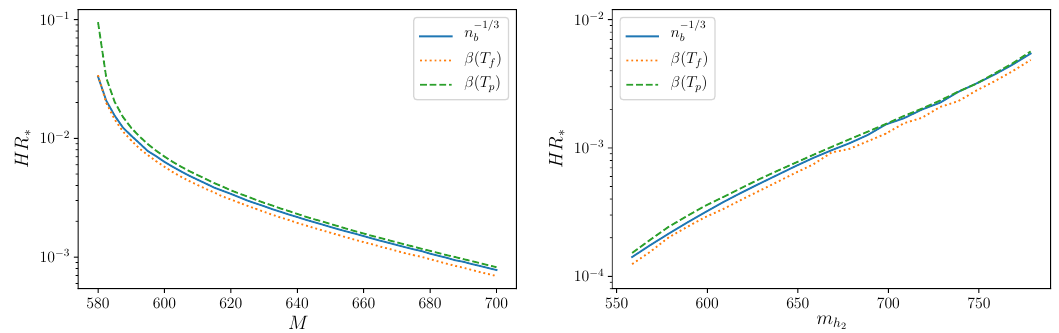
Figure 13 . The mean bubble separation times the Hubble parameter for SMEFT ( left ) and xSM ( right ). The solid line corresponds to the numerically calculated value defined in eq. (4.4) evaluated at T (2.27). The dashed and dotted lines correspond to the estimated value using eq. (4.3) evaluated f at T (2.27) and T (2.11) f p